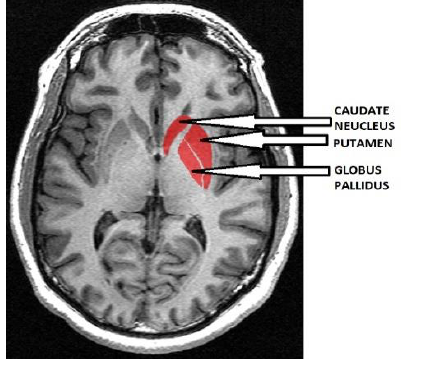
Figure 2: MRI brain scan showing normal anatomy of the